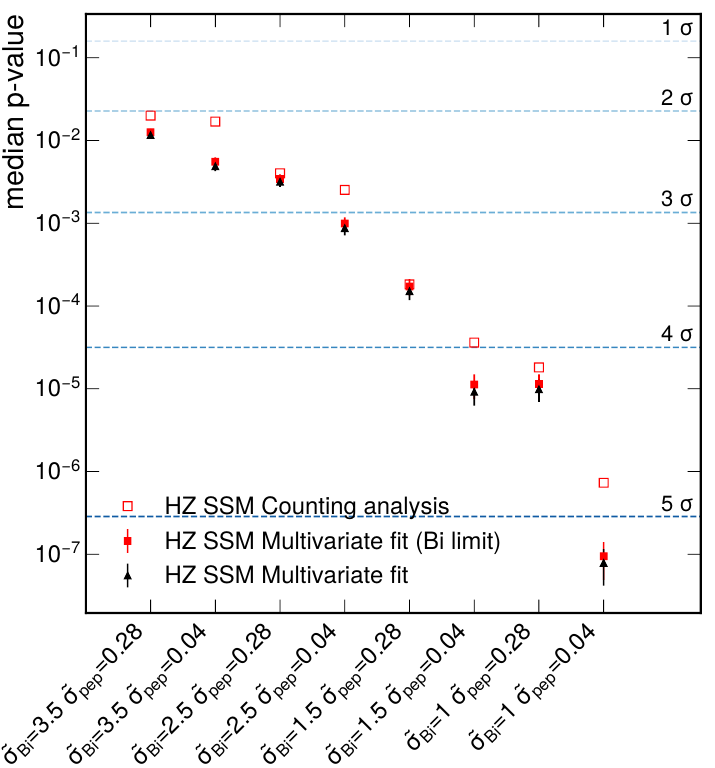
Figure 10. Borexino median discovery significance for the HZ-SSM hypothesis on the CNO rate for the exposure of (1000 71.3)days ton (93% of the Phase III exposure) for the multivariate × × spectral fit (filled markers) and counting analysis (empty square). Different scenarios for the penalties on pep solar neutrino rate and on 210 Bi rate are considered. The uncertainty ∼ σ Bi and ∼ σ pep are in cpd/100ton. For pep , 0.04cpd/100ton corresponds to a 1.4% constraint. For 210 Bi, the LPoF fit returns an uncertainty of 1.3cpd/100ton (Section 3.4.2). From